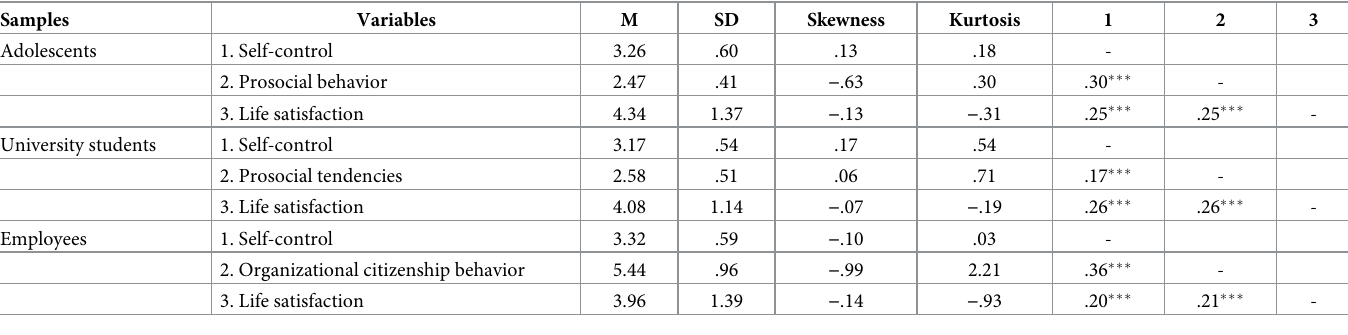
Table 2. Descriptive statistics and correlations of self-control, prosocial behavior, and life satisfaction across the three samples.